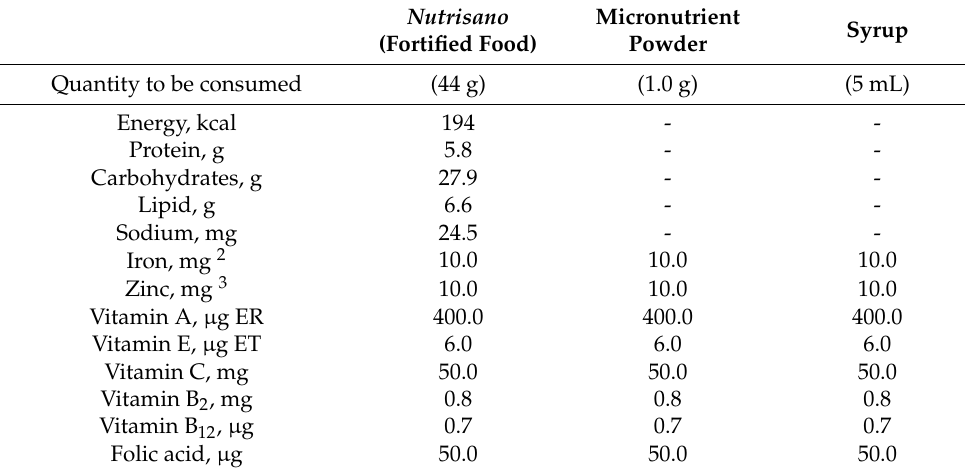
Table 1. Nutritional content of the supplements 1